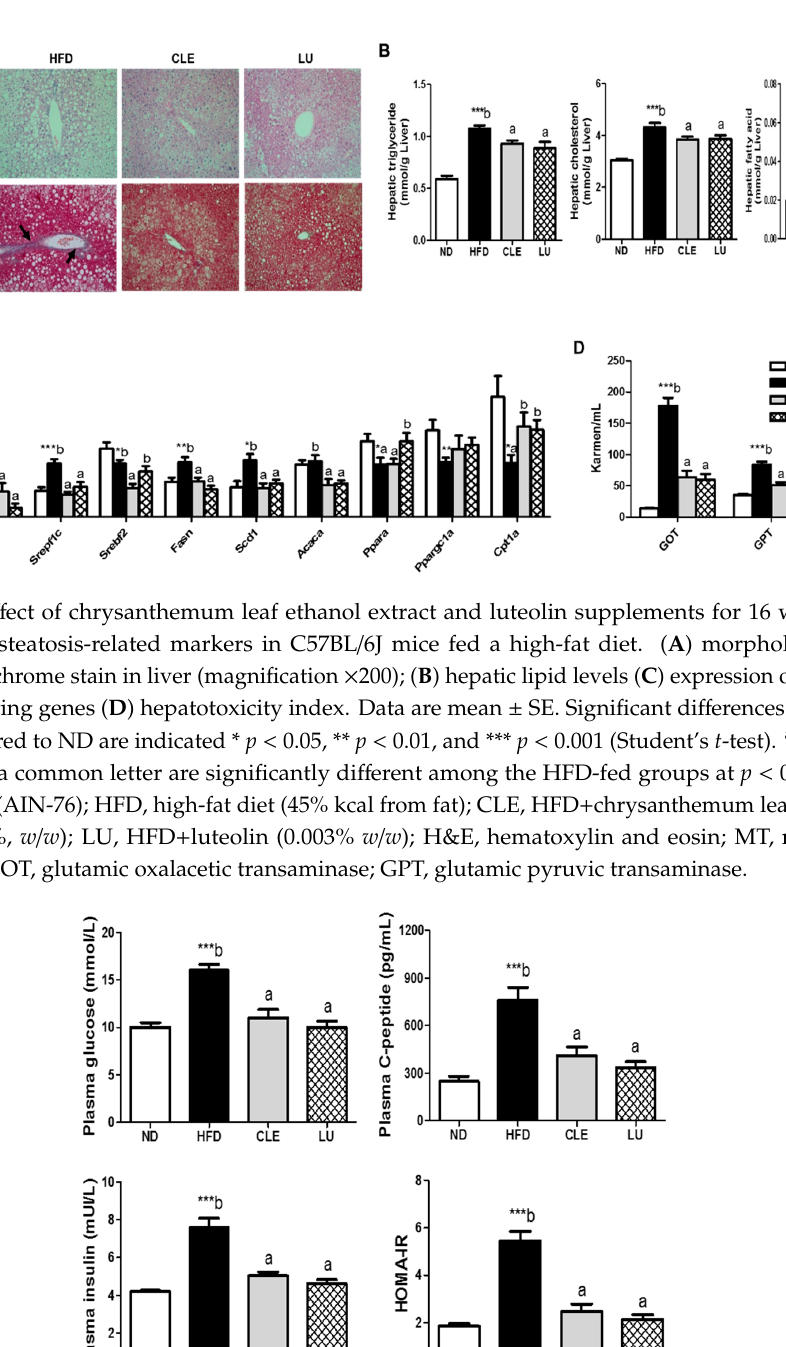
Figure 4. Effects of chrysanthemum leaf ethanol extract and luteolin supplements for 16 weeks on plasma glucose, insulin, C-peptide, and HOMA-IR in C57BL/6J mice fed a high-fat diet. Data are mean ± SE. Significant differences between HFD compared to ND are indicated *** p < 0.001 (Student’s t-test). ab Means not sharing a common letter are significantly different among the HFD-fed groups at p < 0.05. ND, normal diet (AIN-76); HFD, high-fat diet (45% kcal from fat); CLE, HFD + chrysanthemum leaf ethanol extract (1.5%, w / w ); LU, HFD + luteolin (0.003% w / w ); HOMA-IR, homeostasis model assessment of insulin resistance.